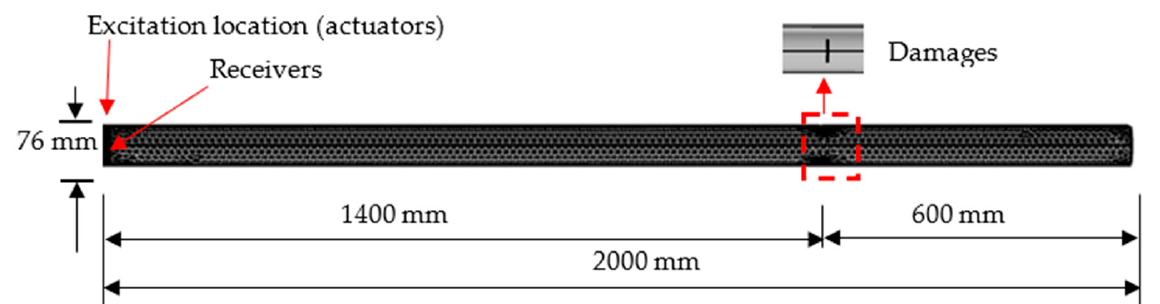
Figure 3. Excited guided waves used in the simulation.